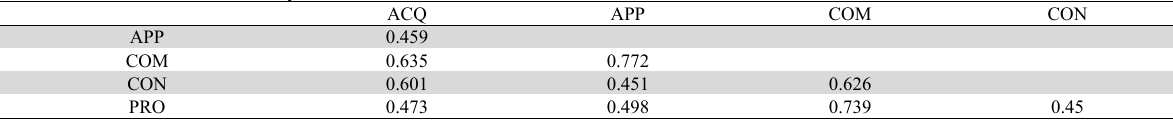
The result of discriminant analysis